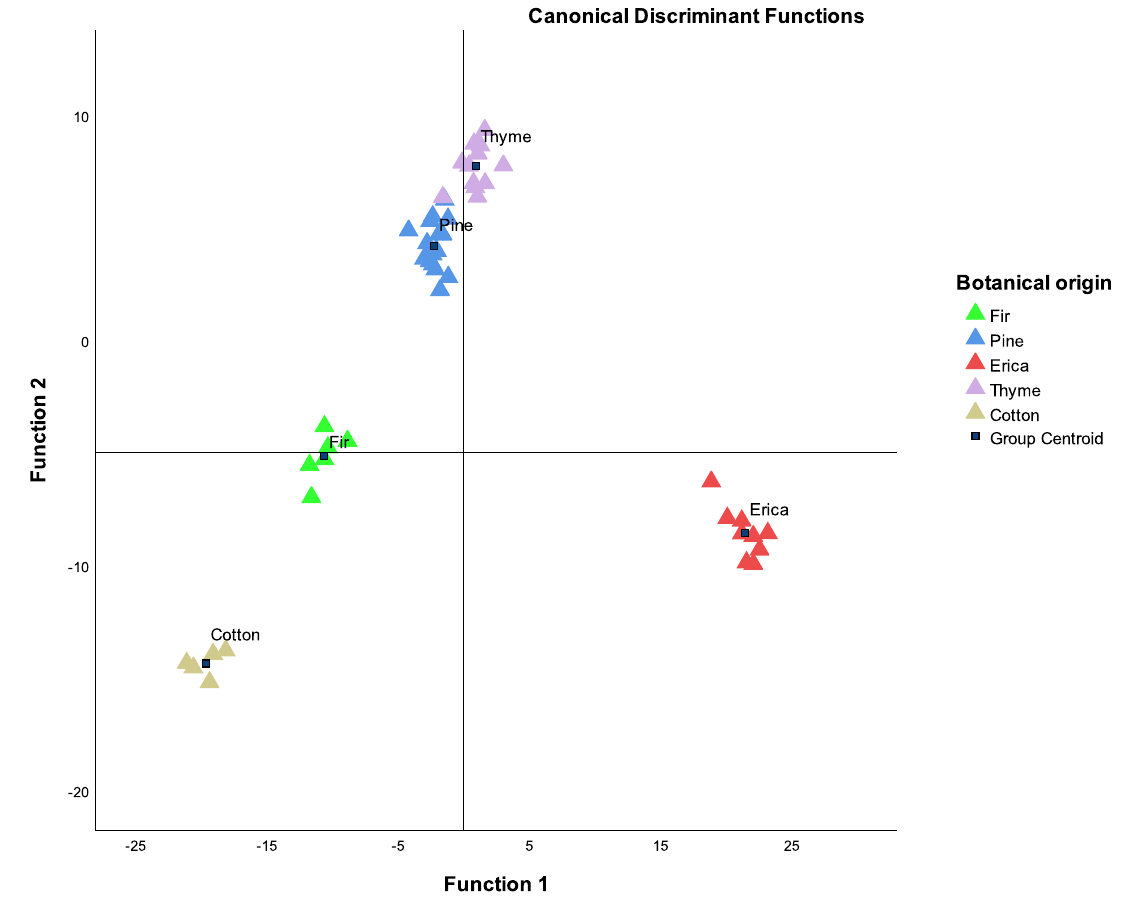
Figure 4. Discrimination of monofloral honey types based on their volatile compound participation, after applying discriminant analysis. Table 3. Classification results (original and cross-validated) extracted from the prediction model after applying SLDA